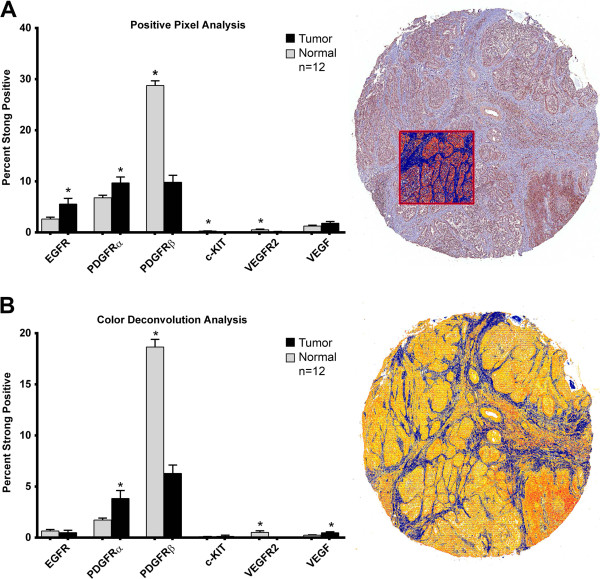
Quantification of TKR immunopositivity in normal and tumor TMA cores using algorithm analysis software. (A) Positive pixel analysis is a digitalized pixel count in a user defined region (red square) of each core as shown in the visual representation of the TMA core for PDGFRα analysis (right). The bar graph represents the percent strong positive pixels for each TKR and VEGF (left). The fraction of strong stained pixels is the number of total pixels (blue and red) minus the negative pixels (blue) in the markup image of the TMA, divided by the number of total stained pixels. (B) Color deconvolution analyses of IHC digitalized images accounted for different staining densities of the entire core. The intensity range markup core of PDGFRα analysis (right) shows intensity ranges as weak positive staining (yellow), medium (orange), strong positive (red) and negative staining (blue). The biospecimen percent of positive pixels strongly stained for TKRs and VEGF are represented in the bar graph on the left. Each bar represents the mean positivity of 36 tumor (black) and 36 normal (grey) TMA cores from 12 dogs. Error bars, mean ± SEM. *cpAC vs. normal: P < .05.